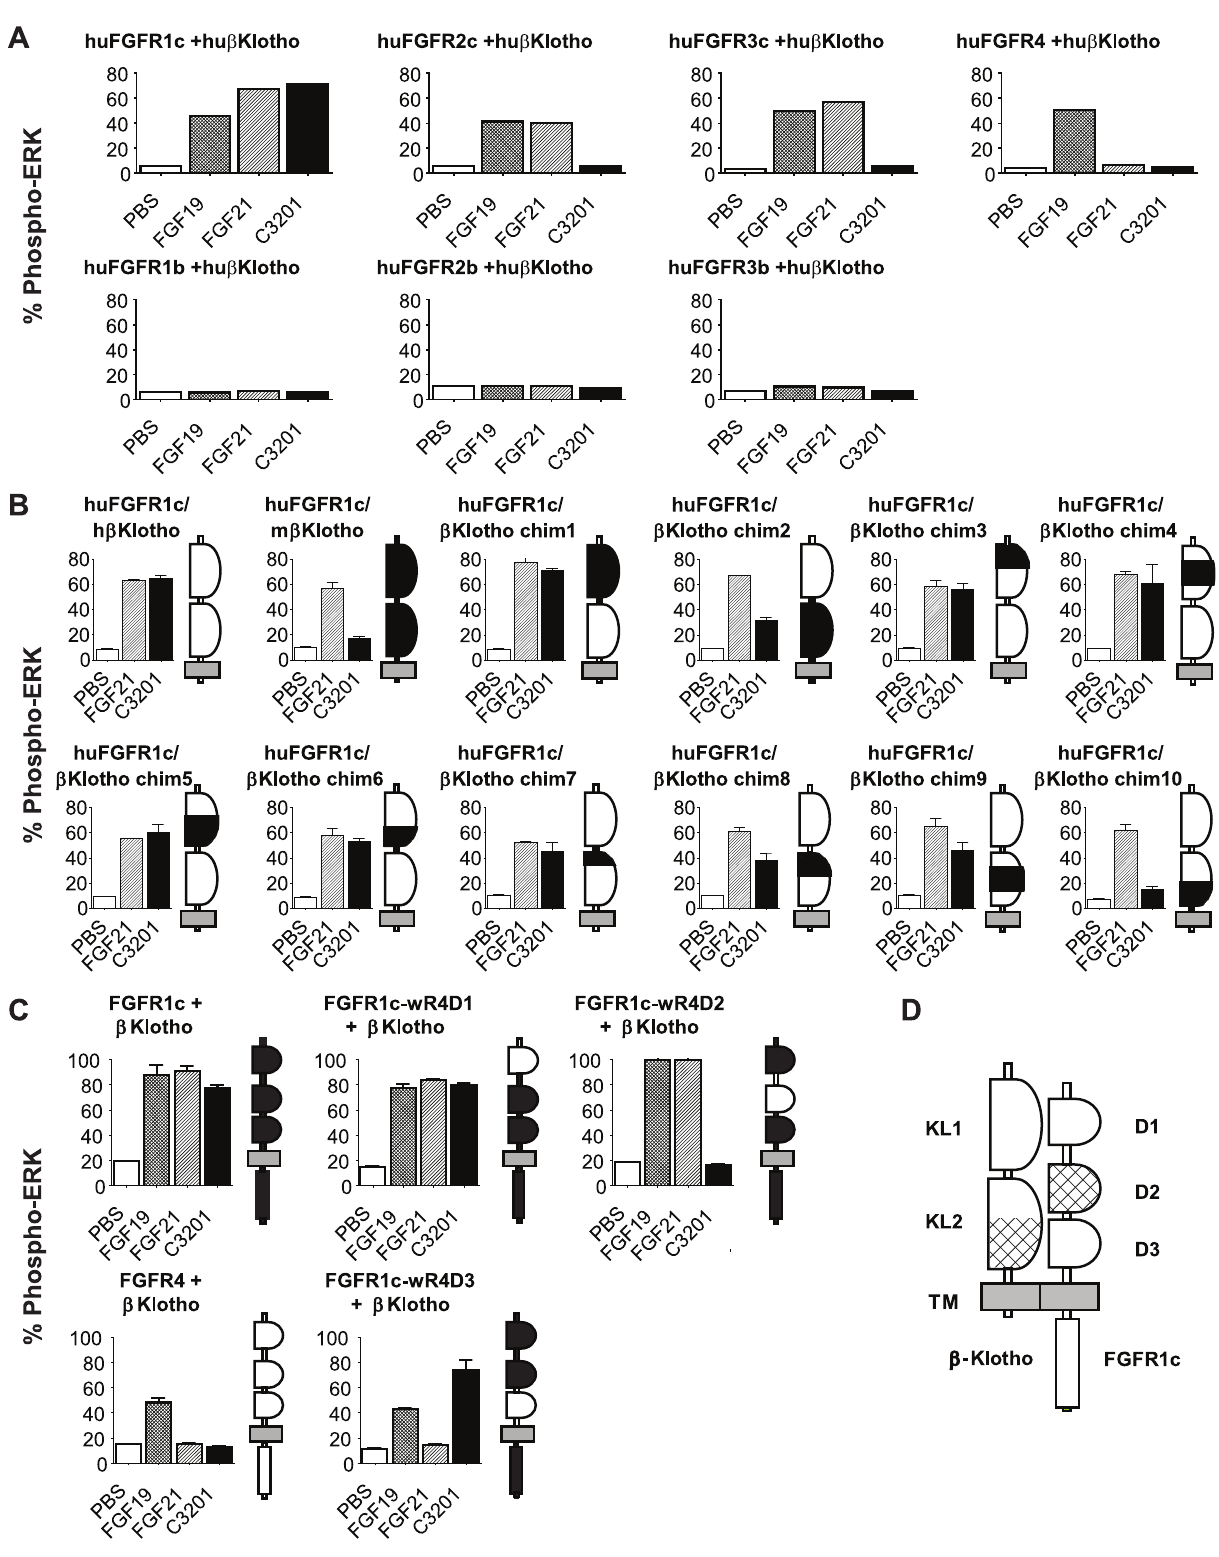
Figure 2. Characterization of binding sites for C3201 on FGFR1c and b -Klotho. (A) C3201 requires FGFR1c and b -Klotho to induce signaling as measured by ERK phosphorylation in L6 cells. L6 cells were selected for this characterization as they do not express any endogenous FGF receptors. Data are expressed as % ERK protein that is phosphorylated, as measured by MSD. (B) Characterization of C3201 binding site on b -Klotho. C3201 does not bind to murine b -Klotho. A series of human-mouse b -Klotho chimeras were co-transfected into L6 cells with human FGFR1c, and signaling was measured by ERK phosphorylation. The b -Klotho chimeras are represented by cartoons next to the ERK phosphorylation histograms, with murine